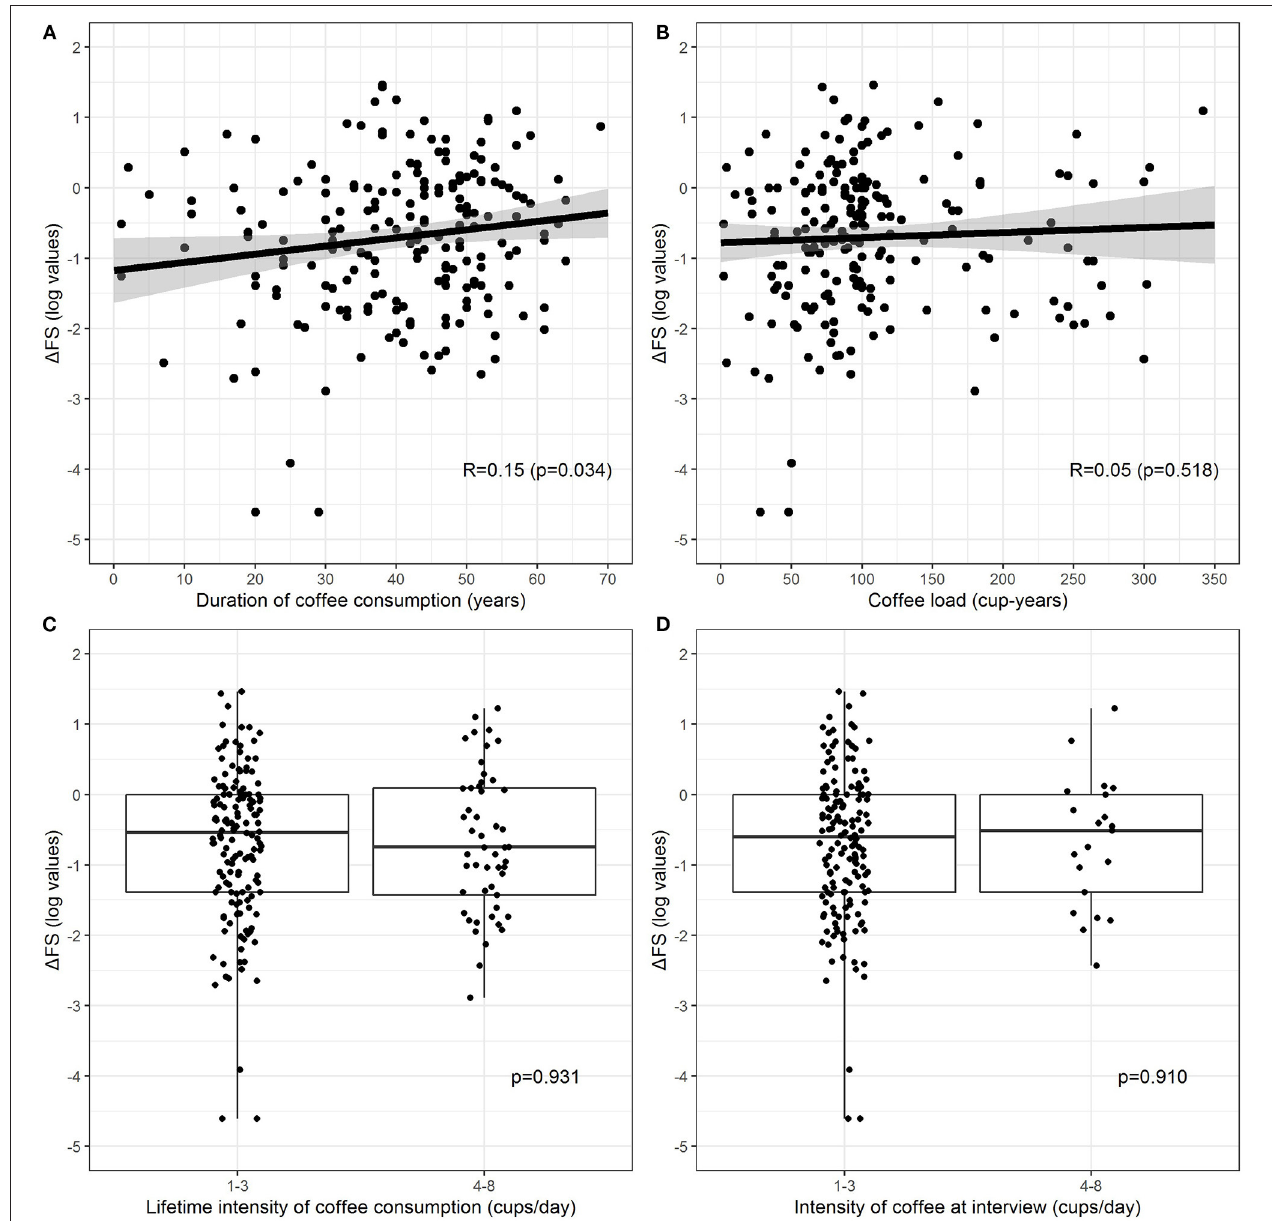
FIGURE 1 | Relationship between log-transformed 1 FS and duration of coffee consumption (A) , coffee lifetime load (B) , lifetime intensity (C) (current and former consumers combine), and intensity at the interview (D) (only current consumers). Patients who consumed decaffeinated coffee were excluded. The relationship between continuous exposures and log-transformed 1 FS (A,B) is graphically represented by a scatterplot with a fitted regression line, along with estimated Pearson correlation coefficient ( R ) and p -value, whereas the association between categorical exposures and log-transformed 1 FS (C,D) is graphically represented by a boxplot, along with p -values from the two-sample t